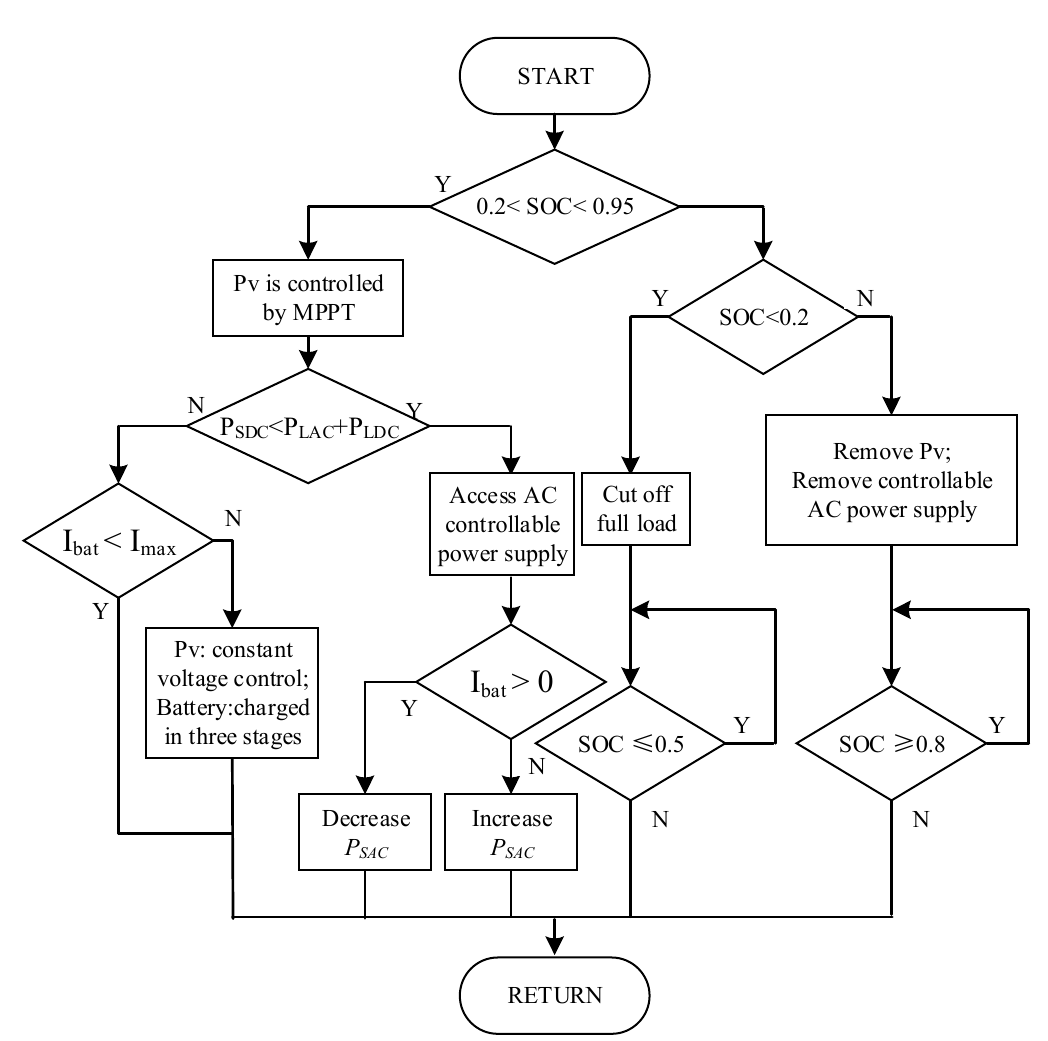
Figure 14. Operation control flow chart of SPEER under isolated network.